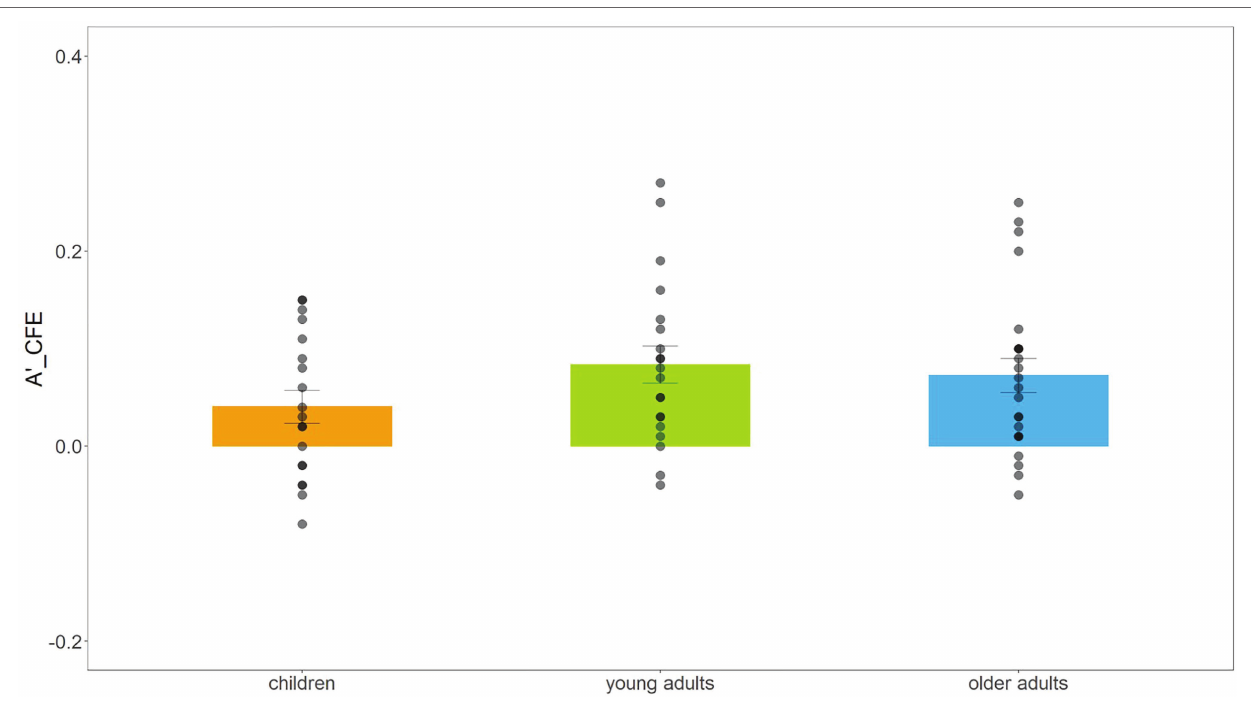
FIGURE 4 | Bar plot with data of CFEA ' (A ' aligned congruent – A ' aligned incongruent ) – (A ' misaligned congruent – A ' misaligned incongruent ) and standard errors of children, young adults, and older adults. The bar plot in the figure shows the mean size of CFEA ' of each group, and the block dots the are the data distribution across